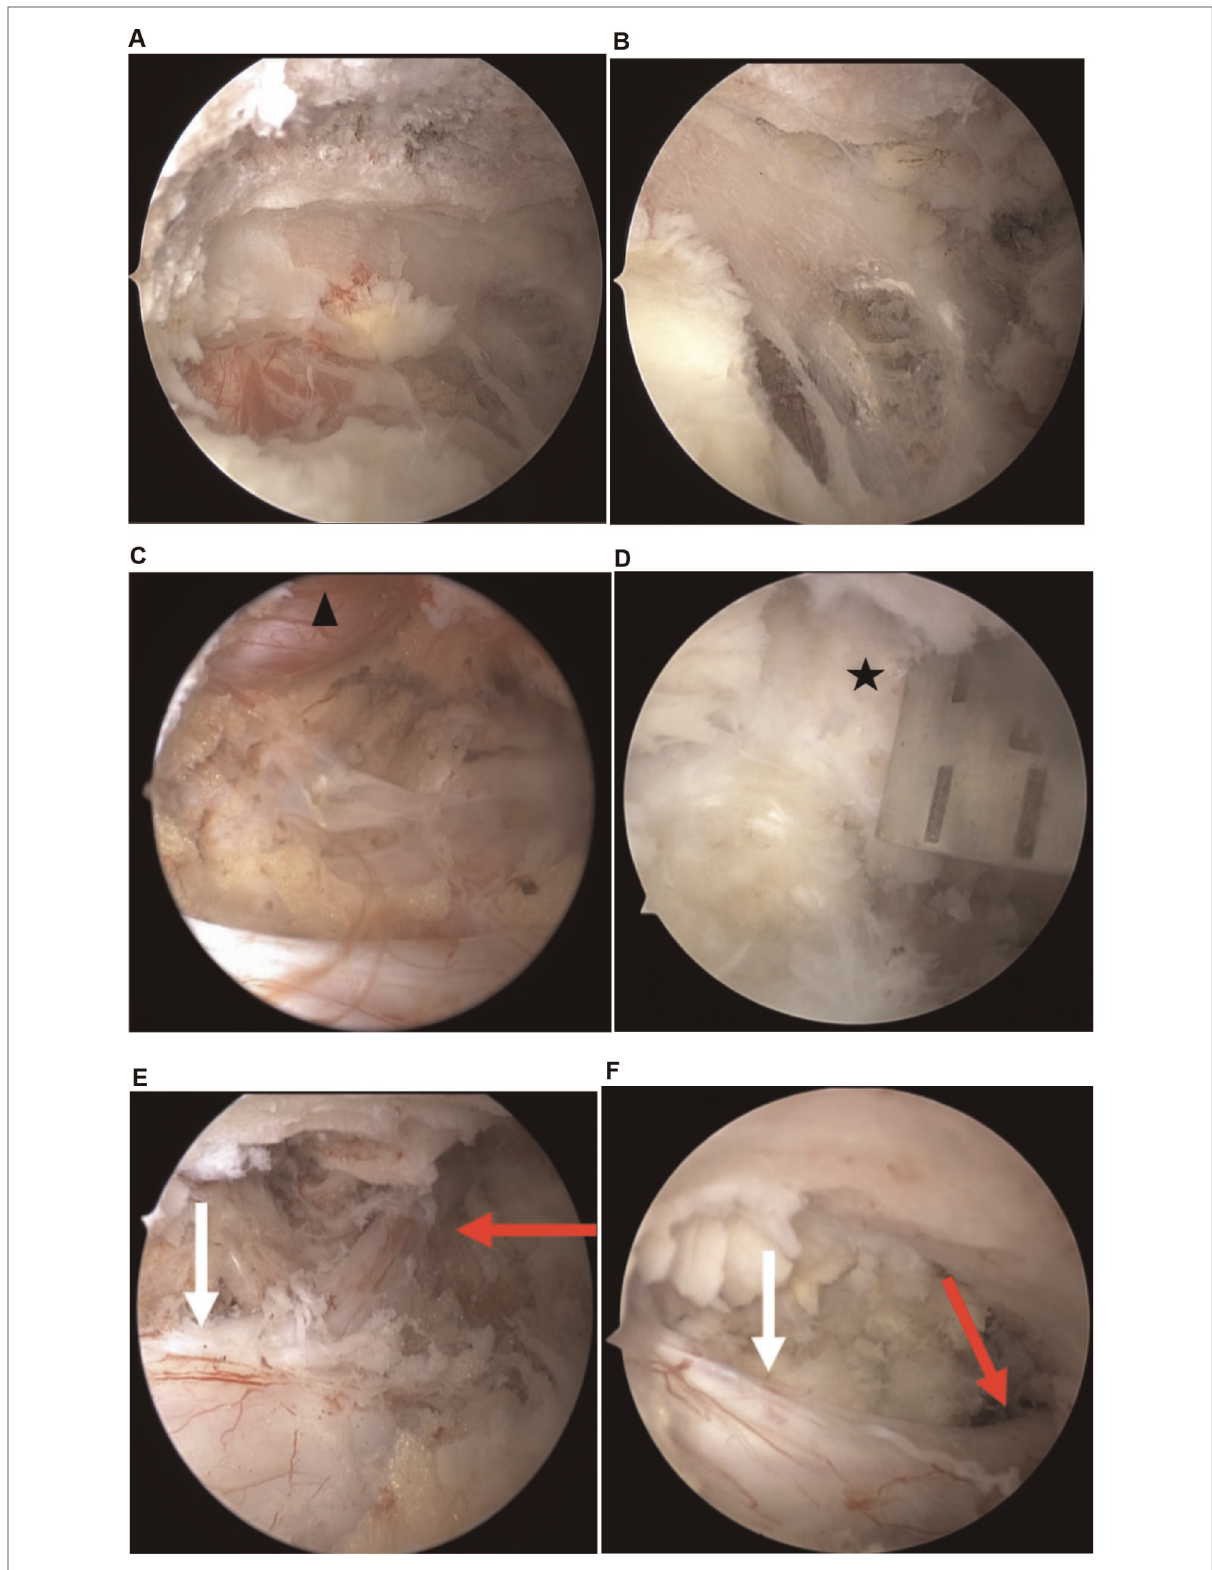
FIGURE 5 Operative illustrations in the endoscopic view. ( A ) Laminotomy of the crania; ( B ) laminotomy of the cauda; ( C ) cranial tip of the superior articular process is cut by an angled chisel; ( D ) decompressed exiting root in foraminal is observed; ( E ) thecal sac and shoulder margin of traversing root were revealed; ( F ) decompressed traversing root is demonstrated (black Asterisk: cranial tip of the superior articular process; black triangle: L5 exiting root; red arrow: L5 traversing root; black arrow: thecal